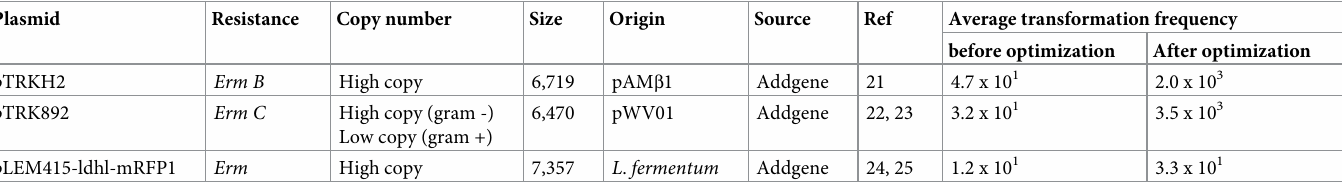
Table 1. Designation, characteristics and transformation frequency of plasmids tested in Lactobacillus jensenii ATCC 25258. Plasmid